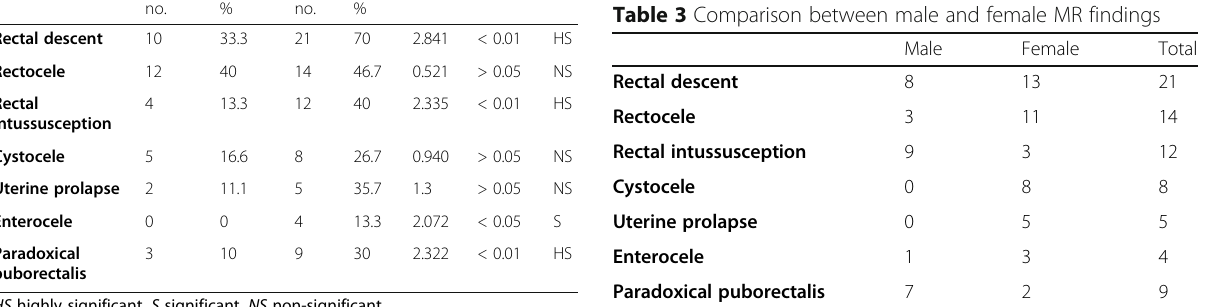
Table 1 Comparison between clinical findings and MRD findings Clinical no.